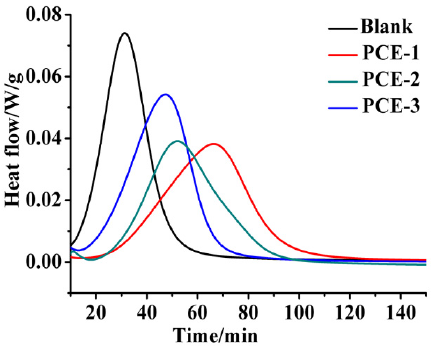
Figure 8. Differential heat flow of β− HH plaster in the absence and presence of PCEs.